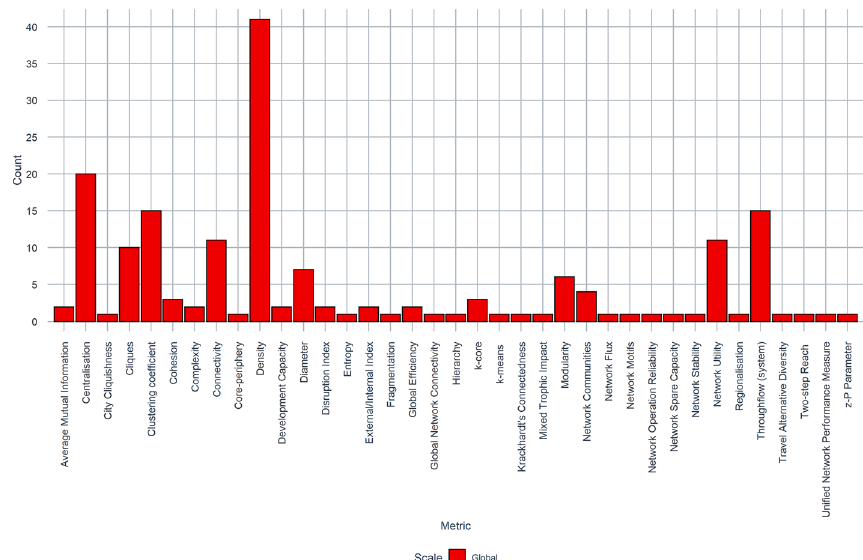
Fig. 6 Frequency of global network